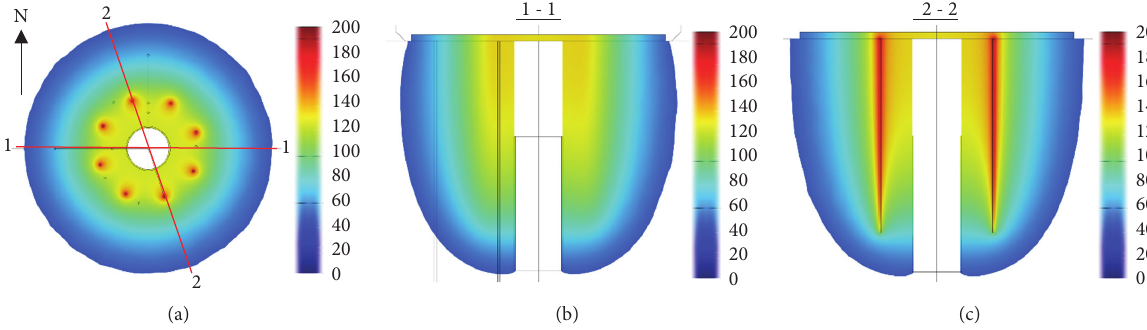
interface remains in compression and no significant